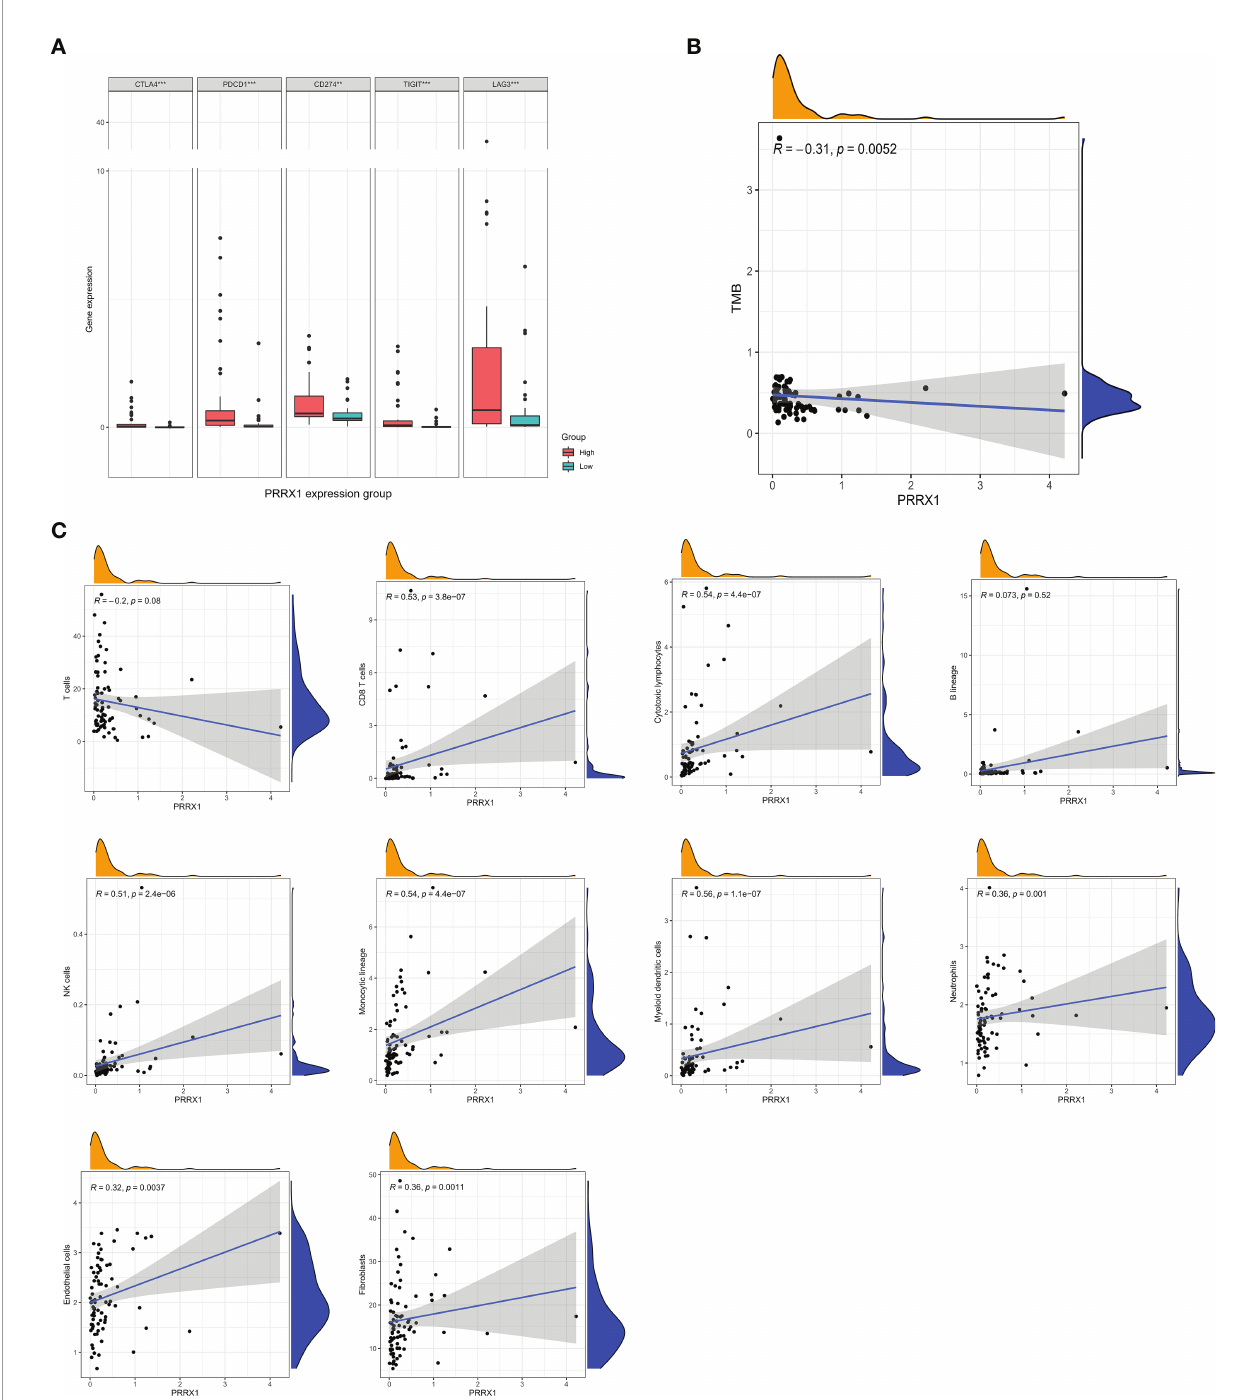
FIGURE 8 | Analysis of immunologic characteristics associated with PRRX1 expression levels. (A) Comparisons of the levels of expression of immune checkpoint genes in the high and low PRRX1 groups (** p < 0.01; *** p < 0.001). (B) Correlation between PRRX1 expression level and TMB. (C) Correlation between PRRX1 expression and tumor immune/stromal cell populations in the UM microenvironment: T cells, CD8 T cells, cytotoxic lymphocytes, B lineage cells, NK cells, cells of the monocytic lineage, myeloid dendritic cells, neutrophils, endothelial cells, and fi broblasts, the x-axis represents the expression levels of PRRX1 , and the y axis is the abundance of TME cells. The density curve on the x and y-axes represents the distribution trend of themselves. The blue line indicates the best fi tted linear models and the shaded area indicates the 95% con fi dence